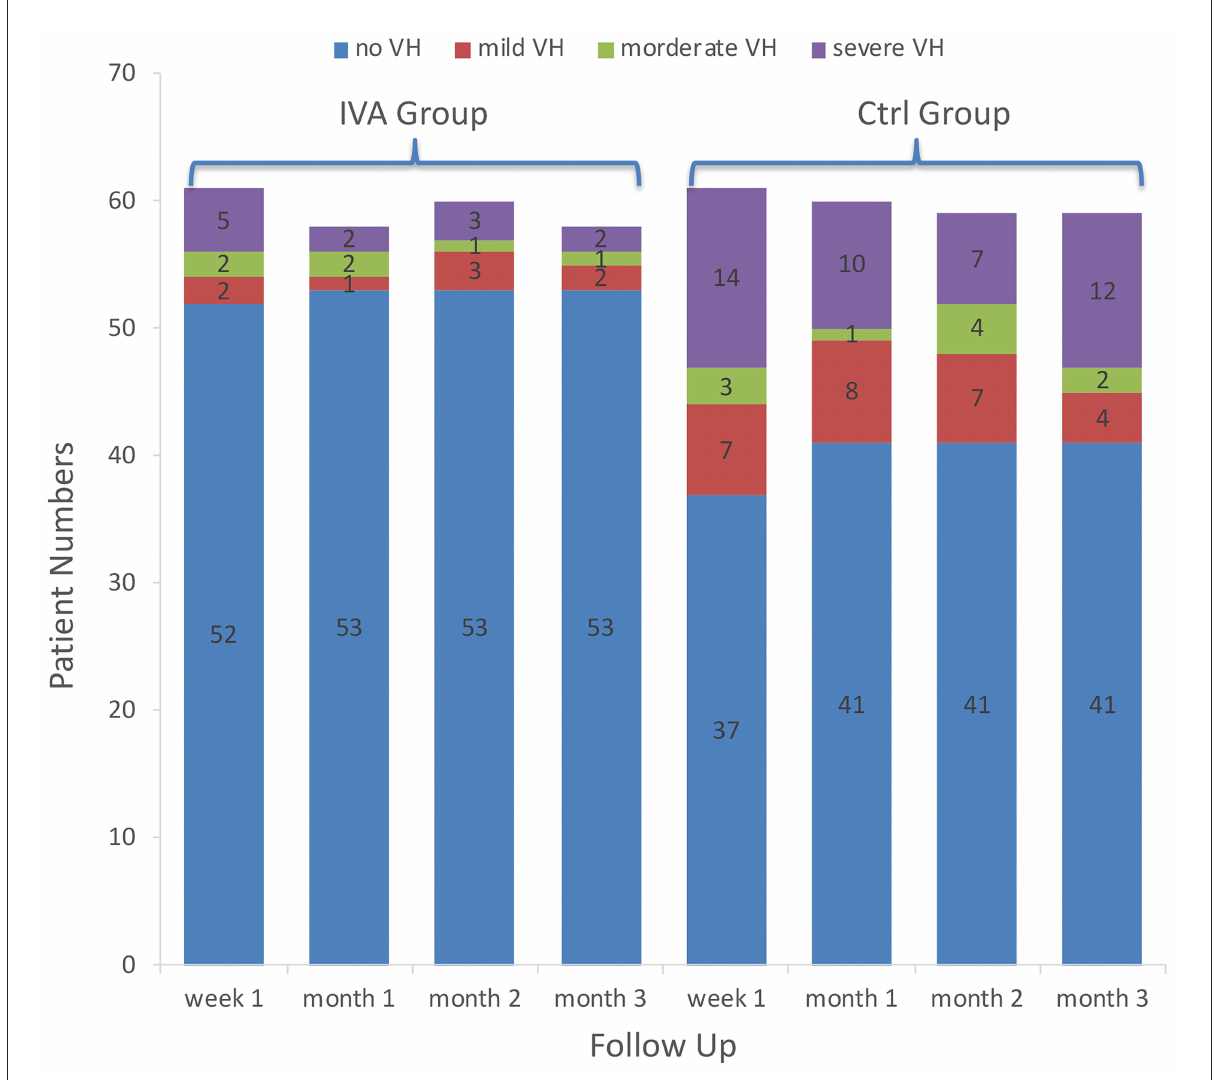
FIGURE1 Vitreous hemorrhage grading in the two groups. The number of patients with different categories of vitreous hemorrhage grading in the preoperative intravitreal aflibercept (IVA) injection group and control group (bar with dotted pattern) during